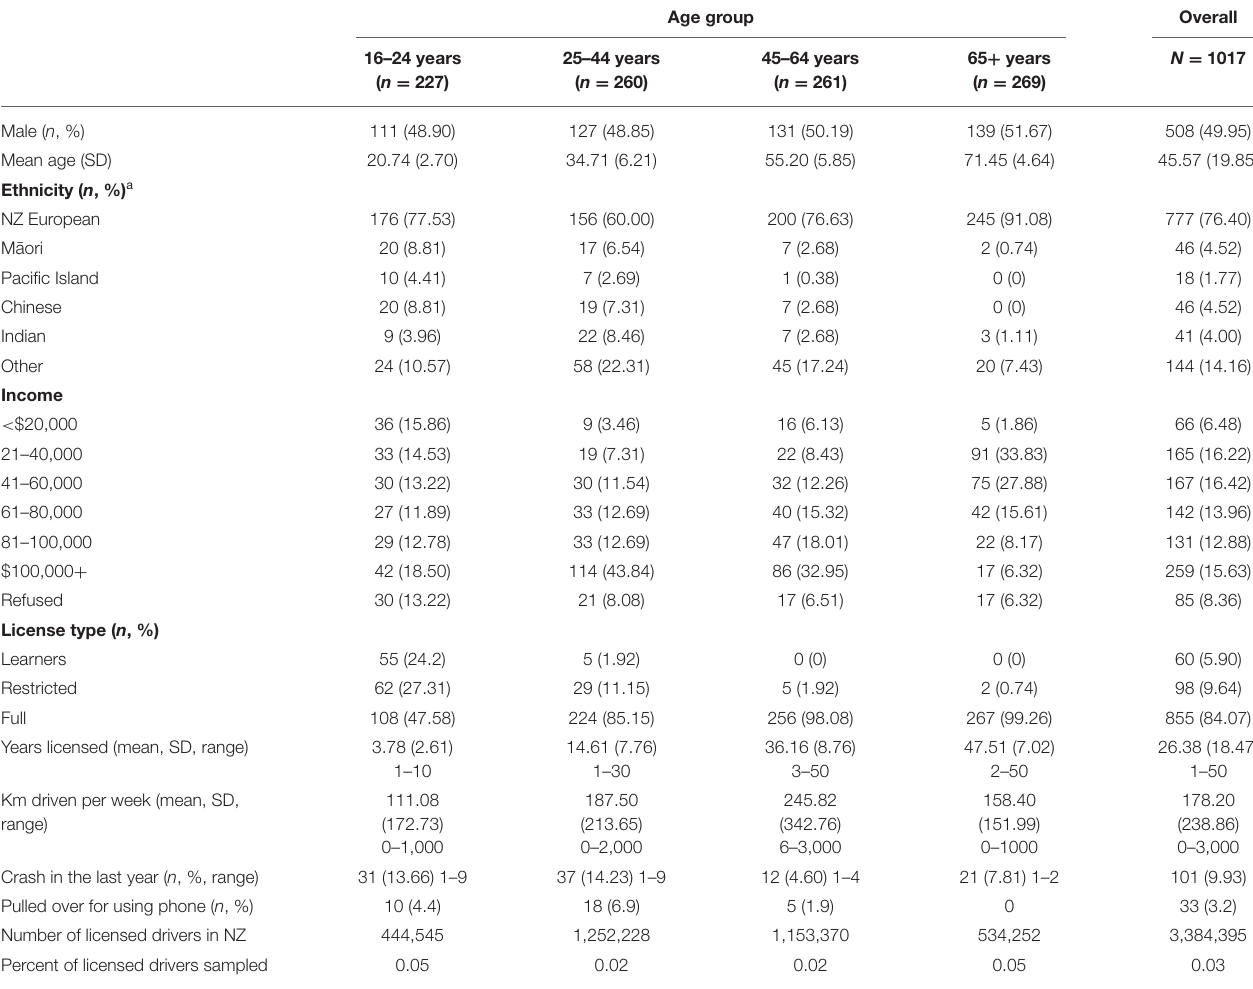
TABLE 1 | Demographic characteristics and driving history of the